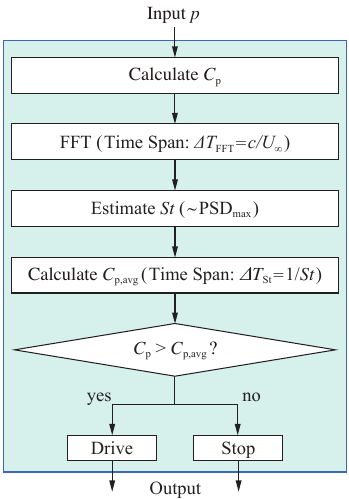
Figure 14. Control flowchart of the DTM.